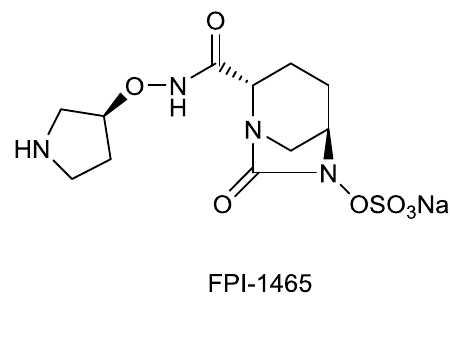
Figure 11. Chemical structure of FPI-1465.